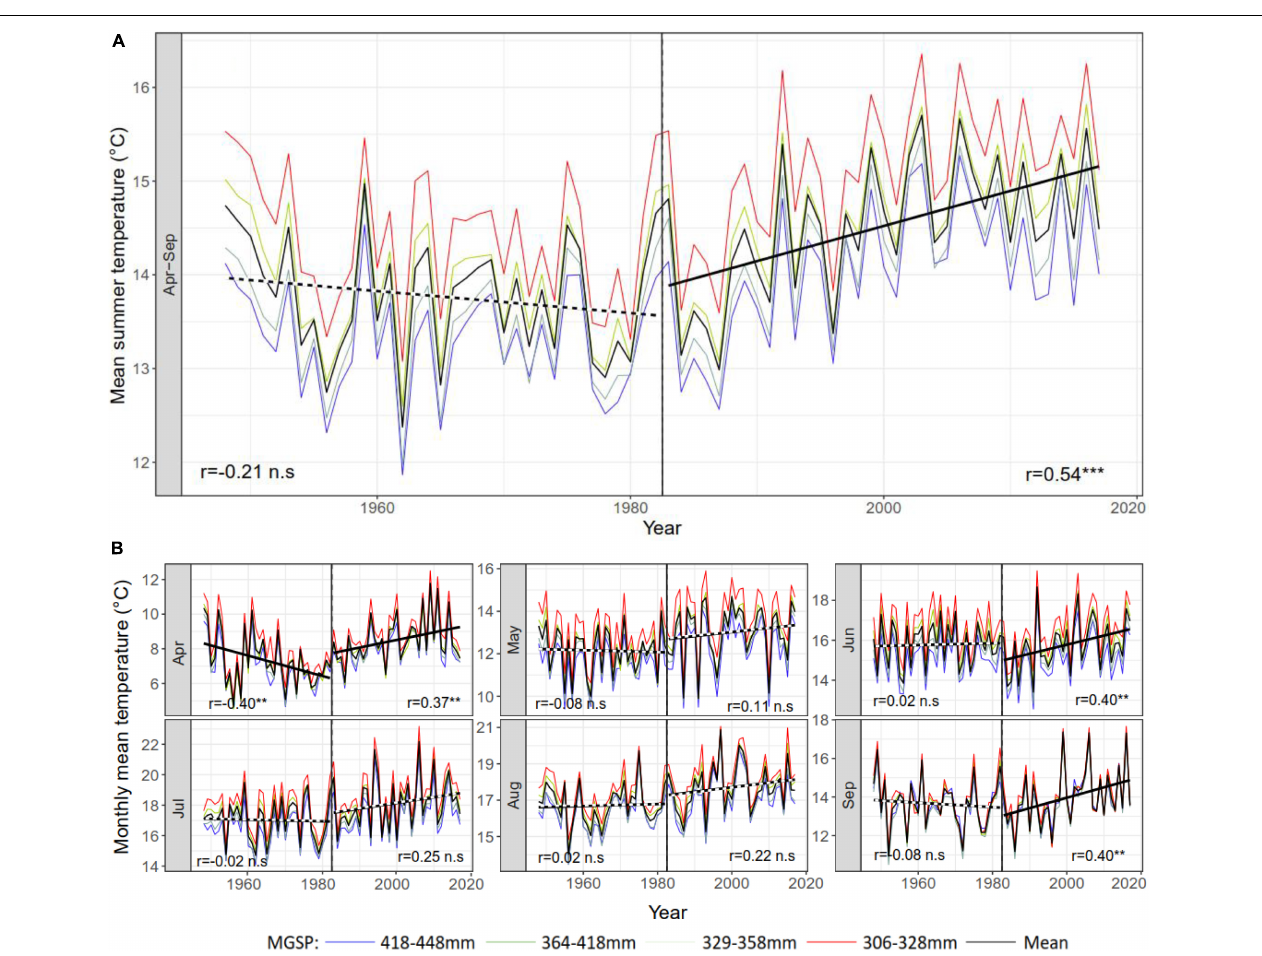
FIGURE 2 | Long-term trends (A) of mean summer temperature (mean of the months April–September) and (B) of the mean temperature of individual summer months in the periods 1948–1982 and 1983–2017 extracted from the gridded climate data of the DWD for the 30 study sites in the North German Lowlands, separately displayed for four classes of mean growing season precipitation (April–September; red: Driest sites, blue: Wettest sites). Significant trends are marked by solid trend lines ( p < 0.05), non-significant ones by dotted trend lines. * p < 0.05 (not applicable in this graph), ** p < 0.01, *** p < 0.001 according to a Mann-Kendall trend